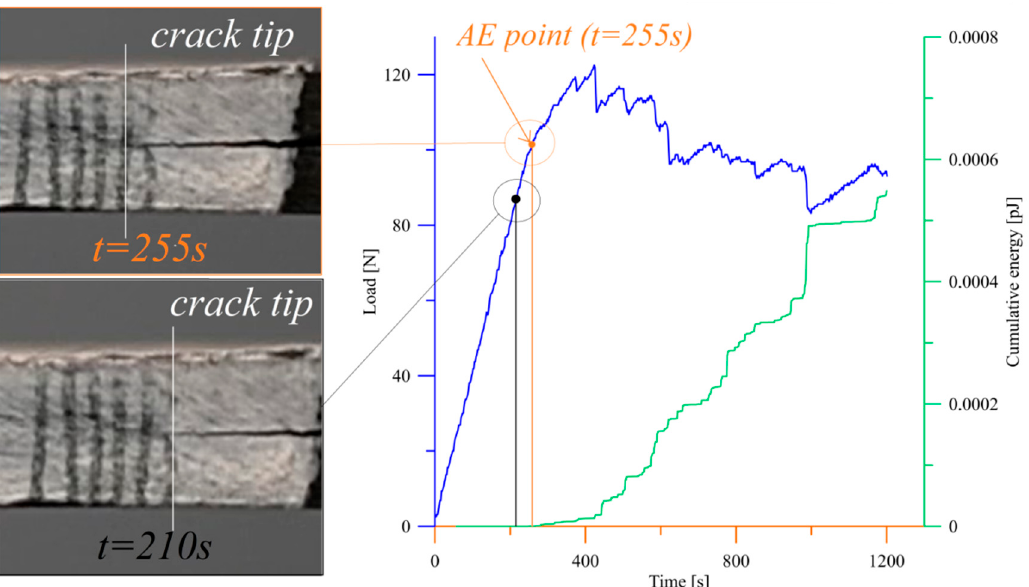
Figure 2. Acoustic emission test set up.